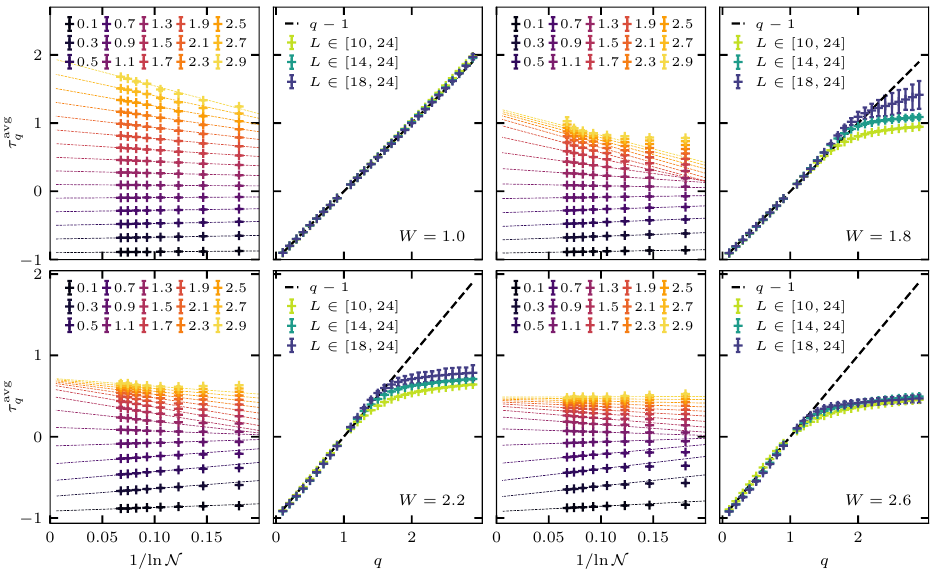
N ,avg Figure 2: Odd columns . Finite size τ data (6) as a function of 1 / ln N for various q values of q (0 < q < 3, darker shade of green indicates smaller q ) and disorder strengths W = 1.0,1.8,2.2 and 2.6. Statistical errors are smaller than symbol size in all plots. Dashed lines are extrapolation of the data to N → ∞ using a linear function in 1 / ln N . Even columns . Extrapolated τ avg as a function of q and various q extrapolation ranges indicated in the legend. Darker colors indicate more weight to larger system sizes. The dashed black line indicates q − 1, which corresponds τ avg of q the GOE